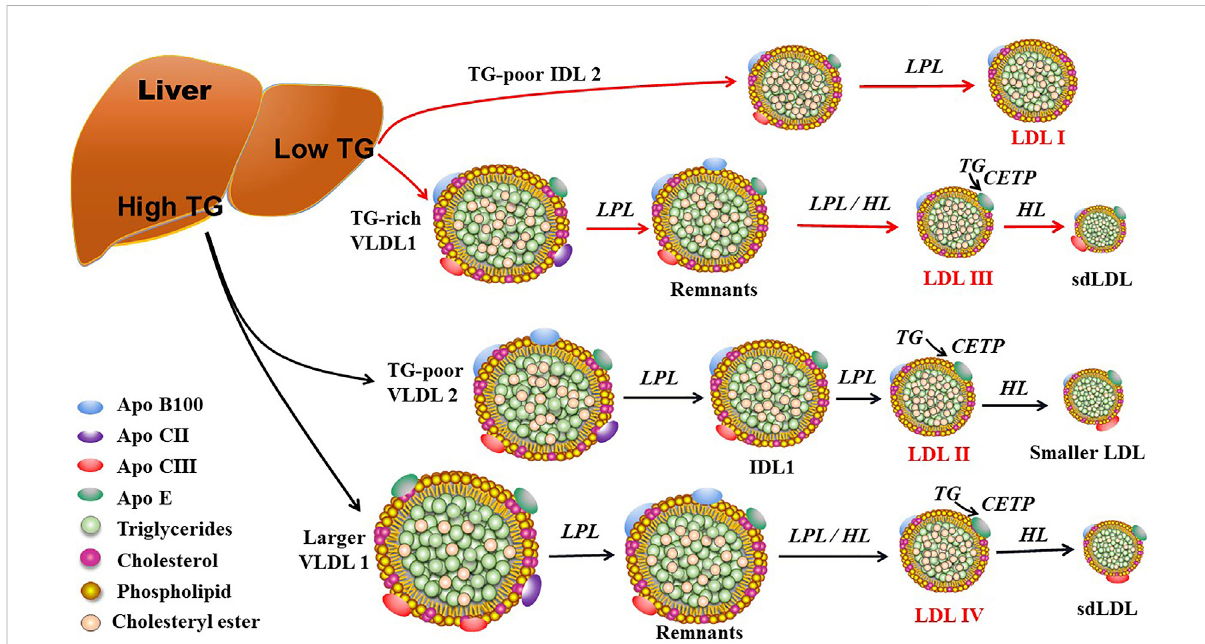
The proposed mechanisms for production of LDL subclasses I, II, III, and IV. LDL subclasses II, III, and IV can be further modulated by hepatic lipase (HL) and cholesteryl ester transfer protein (CETP). Of note, LDL subclasses III and IV are responsible for the production of small dense LDL (sdLDL).LPL:lipoproteinlipase;TG:triglyceride;VLDL,verylow-densitylipoprotein;IDL2:intermediatedensitylipoprotein2;IDL1:intermediatelow- density lipoprotein